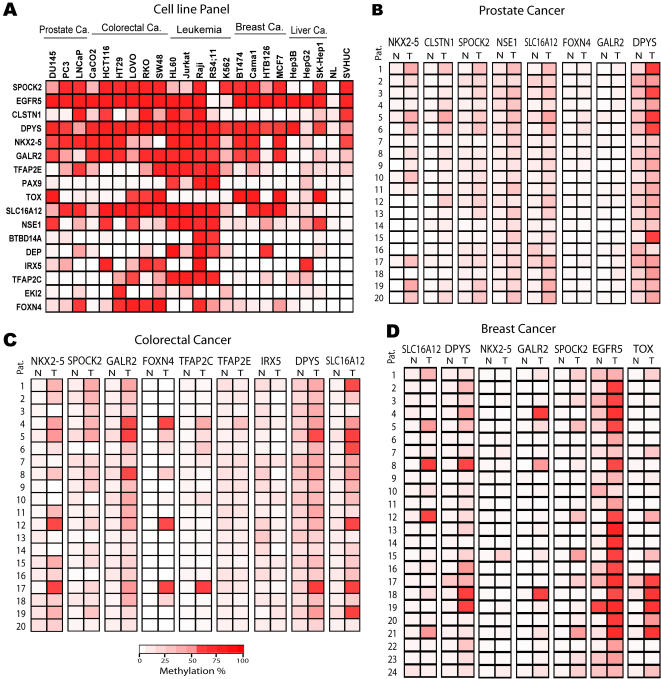
Heat map of DNA methylation profiling of identified clones by MCA-RDA.The bottom red-scale bar refers to the degree of methylation as measured by COBRA and/or pyrosequencing. NL represents normal leukocyte. A. All of the 17 genes investigated were methylated in at least 2 cell lines of a 21-cell line panel investigated. B. Methylation map for 8 genes studied in twenty primary prostate cancers (T) and paired normal (N) prostate samples. C. Methylation map for 9 genes studied in twenty primary colon cancers (T) and paired normal (N) colon samples. D. Methylation map of 7 genes in twenty-four breast cancers (T) and paired normal (N) samples. Pat.; patient samples.